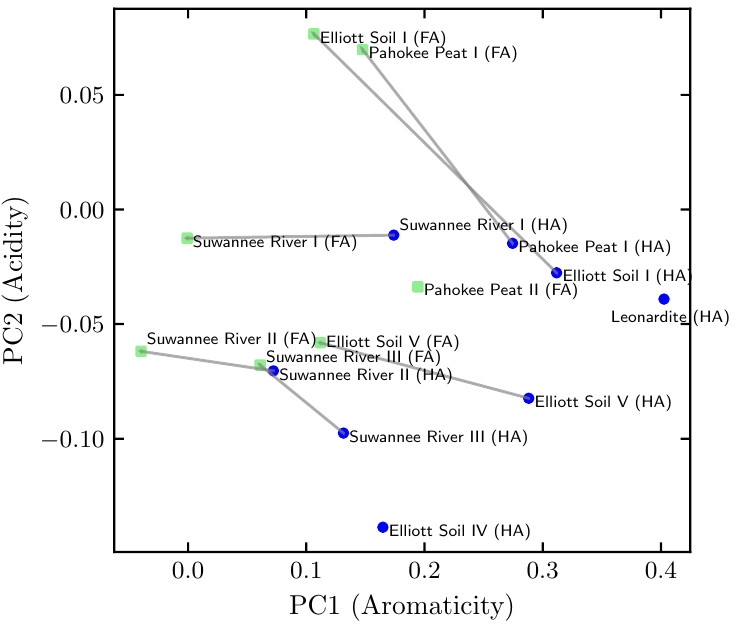
Figure 1. Principal component analysis of the humic substances according to their organic compo- sition. Each point represents a different sample of HS. Blue circles represent humic acids; mean- while, green squares represent fulvic acids. Arrows connect humic substances extracted from the same